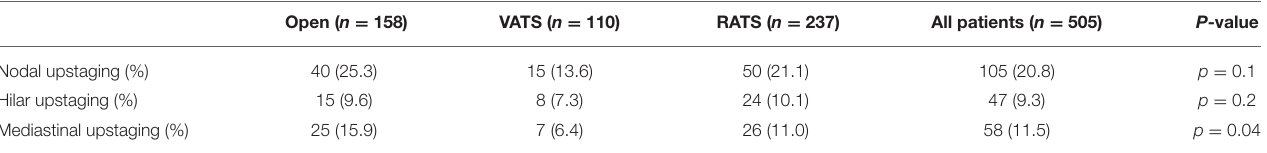
TABLE 3 | Nodal upstaging in the Robotic, VATS, and Thoracotomy groups.